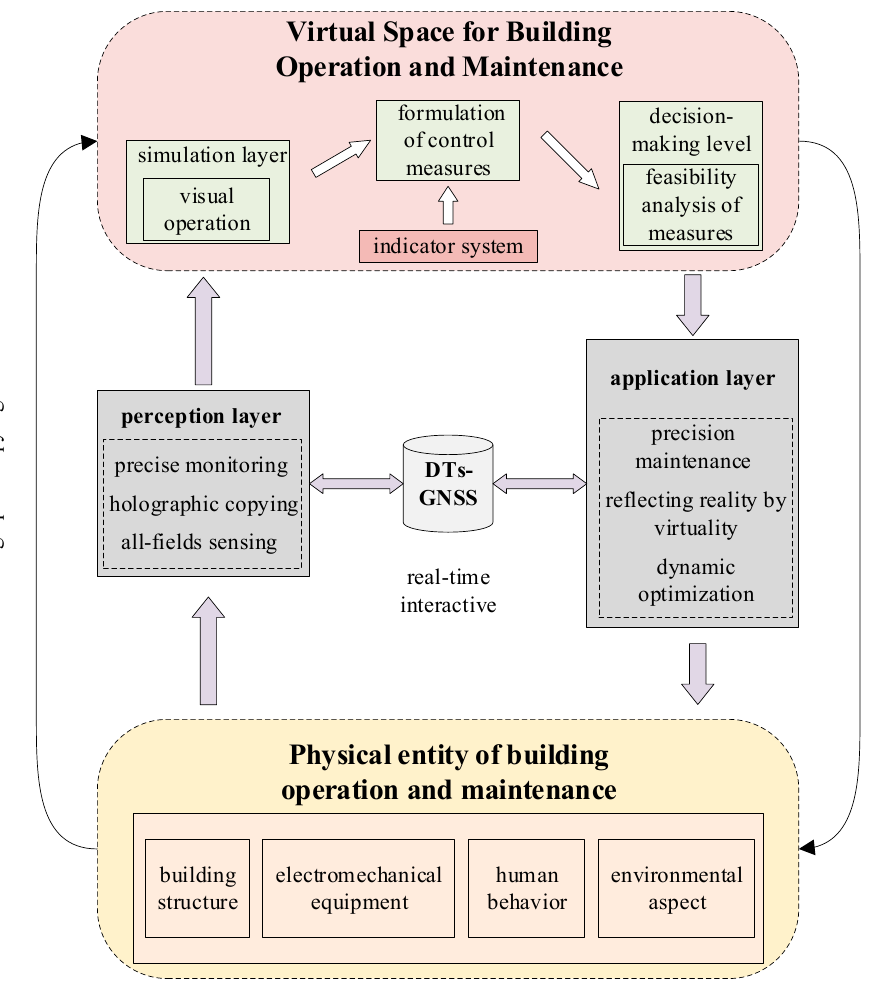
Figure 8. Architecture of intelligent O&M decision control